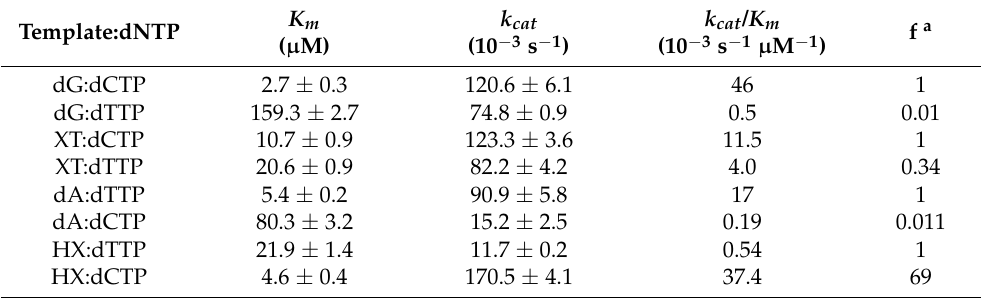
Table 5. Kinetic parameters for nucleotide incorporation opposite XT and HX by pol η [41,89,90].